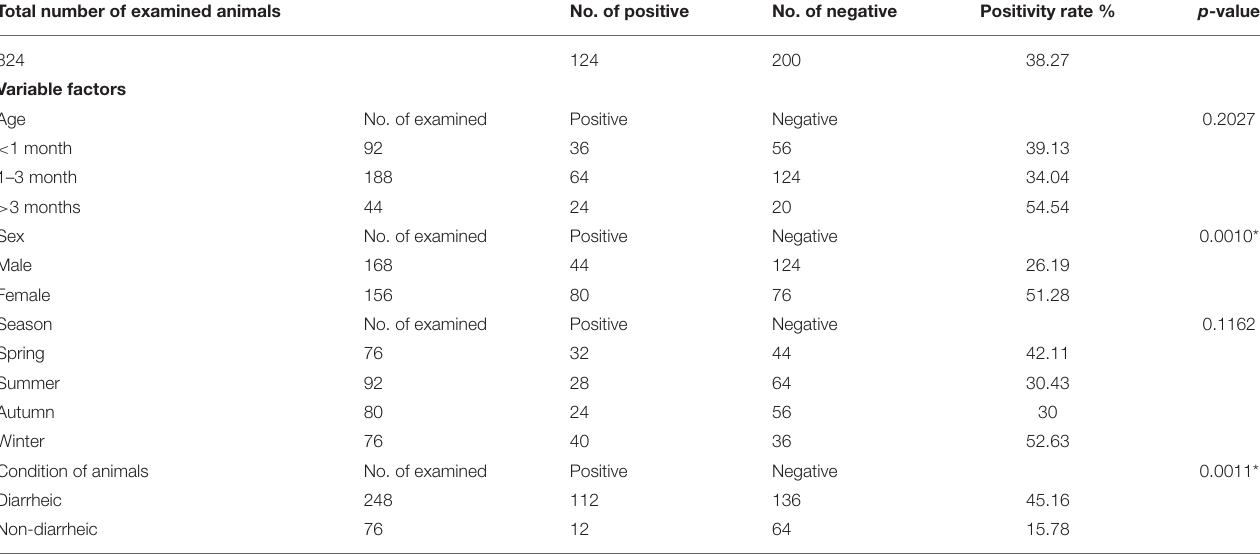
TABLE 6 | Summarizes the data of the possible associations between the occurrence of Cryptosporidium spp. in cattle calves and the potential explanatory individual variable factors of these detected species. Total number of examined